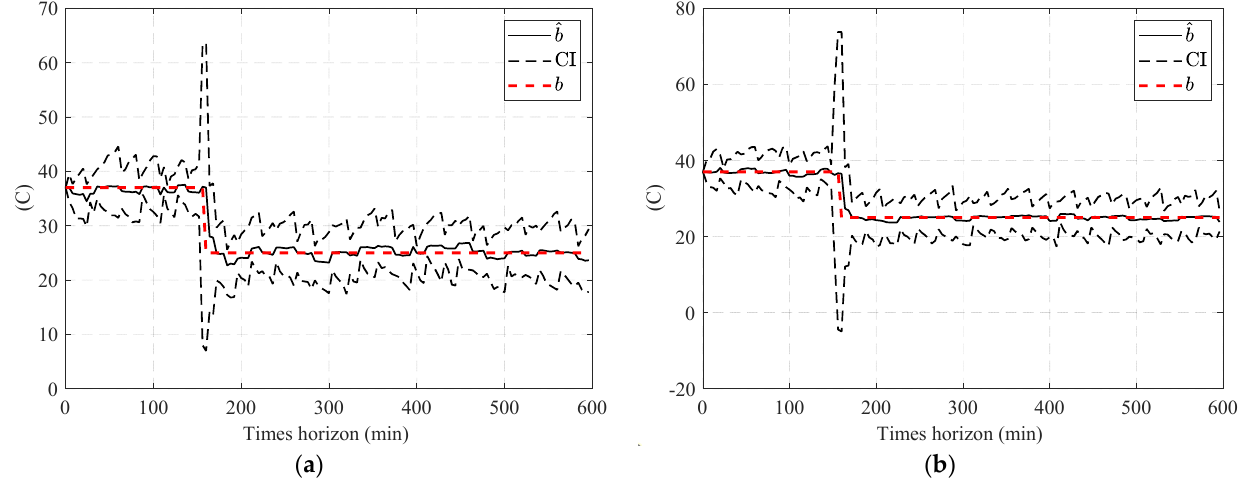
Figure 16. Result of the estimated ˆ b using the two-step method and estimated the lubricant’s temperature via: ( a ) PF and ( b ) APF.